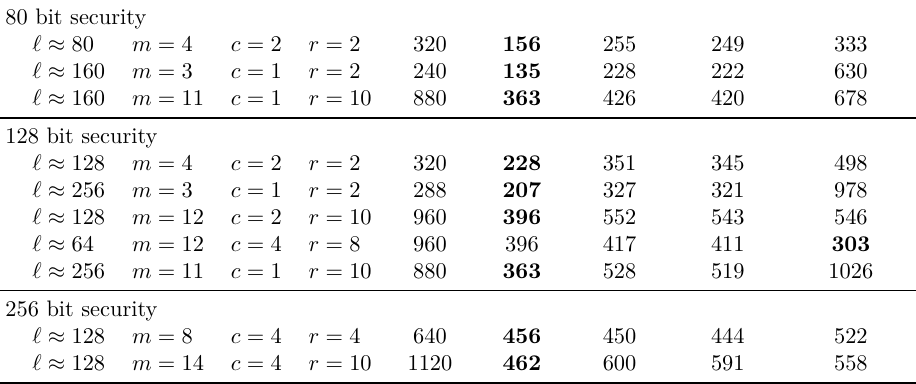
Table 2: Comparison of Vision , Rescue , Starkad , Poseidon , and GMiMC erf over AIR where ‘ denotes the bit-size of the base field, c denotes the capacity of the sponge in terms of field elements and r its rate. The efficiency is given by w · t · d which is the product between the length and the width of the trace together with the degree of the constraints.